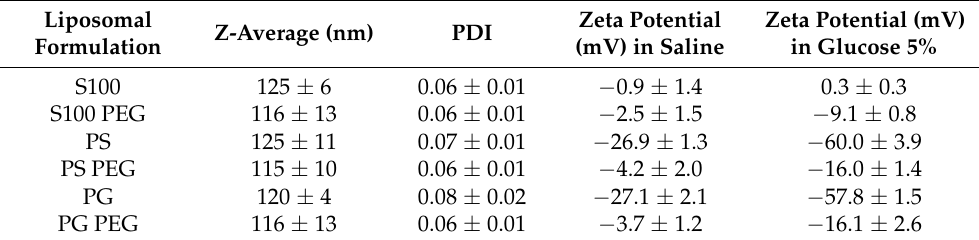
Table 1. Particle size (Z-Average), size distribution (polydispersity index, PDI) and zeta potential values of different liposomal formulations. Data are shown as mean and SD (n =